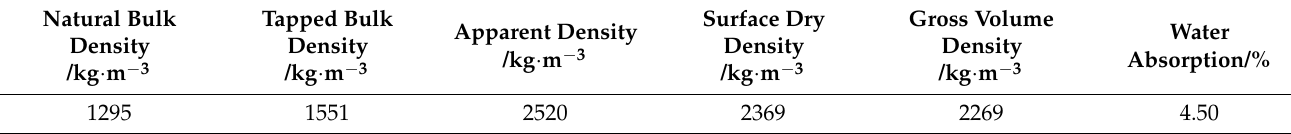
Table 1. Basic physical parameters of crushed gangue.